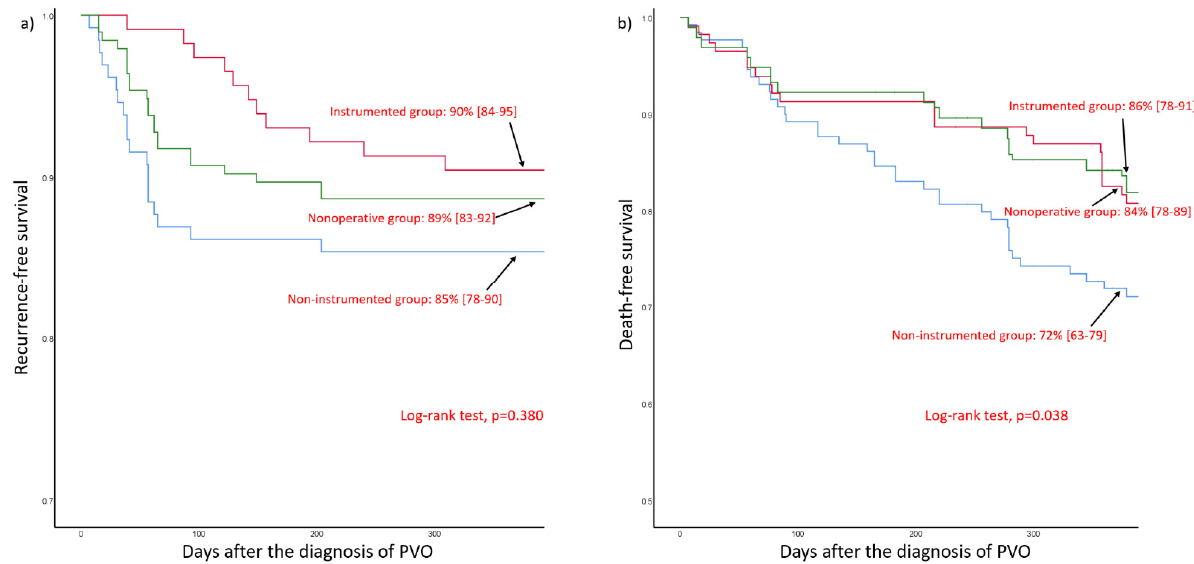
Figure 2. Kaplan–Meier survival curves. ( a ) Recurrence-free survival. ( b ) Death-free survival. Survival probabilities and corresponding 95% confidence intervals at 1-year follow-up are presented.